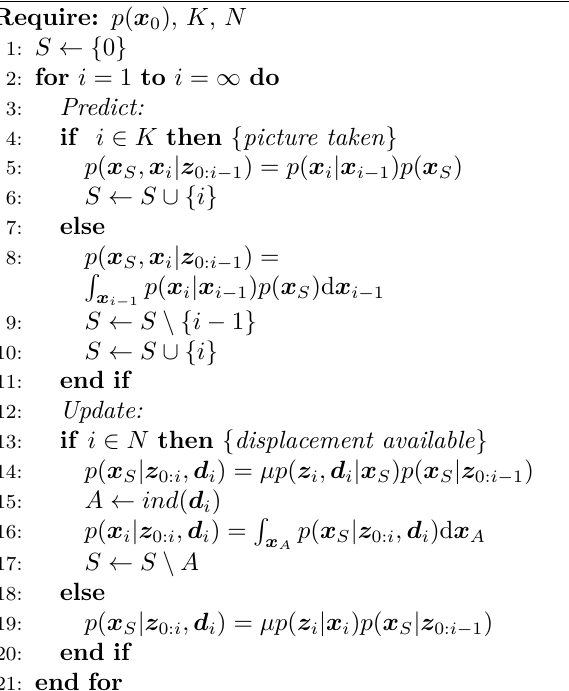
Algorithm 1 Bayesian delayed displacement